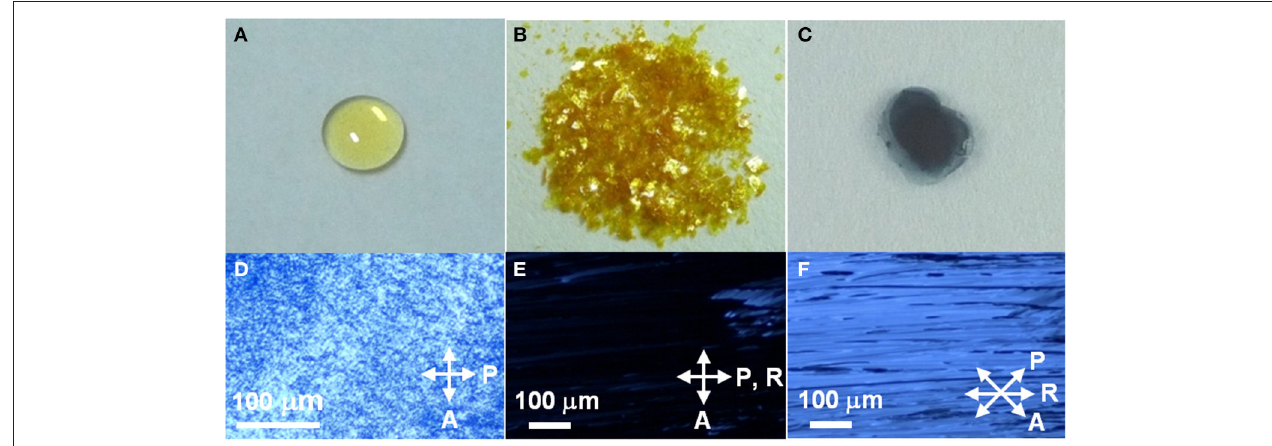
FIGURE 1 | Photographs of (A) DHP(8-12) , (B) TCNQ, (C) DHP(8-12)-TCNQ , and (D–F) optical micrographs of the cast films of DHP(8-12)-TCNQ between crossed polarizer (P) and analyzer (A) for different orientations of the sample, given by the angle θ between the rubbing direction (R) and P. (D) as cast film, (E) after rubbing, θ = 0 ◦ , (F) θ = 45 ◦ . Arrows indicate the directions of the analyzer (A), a polarizer (P), and rubbing (R).